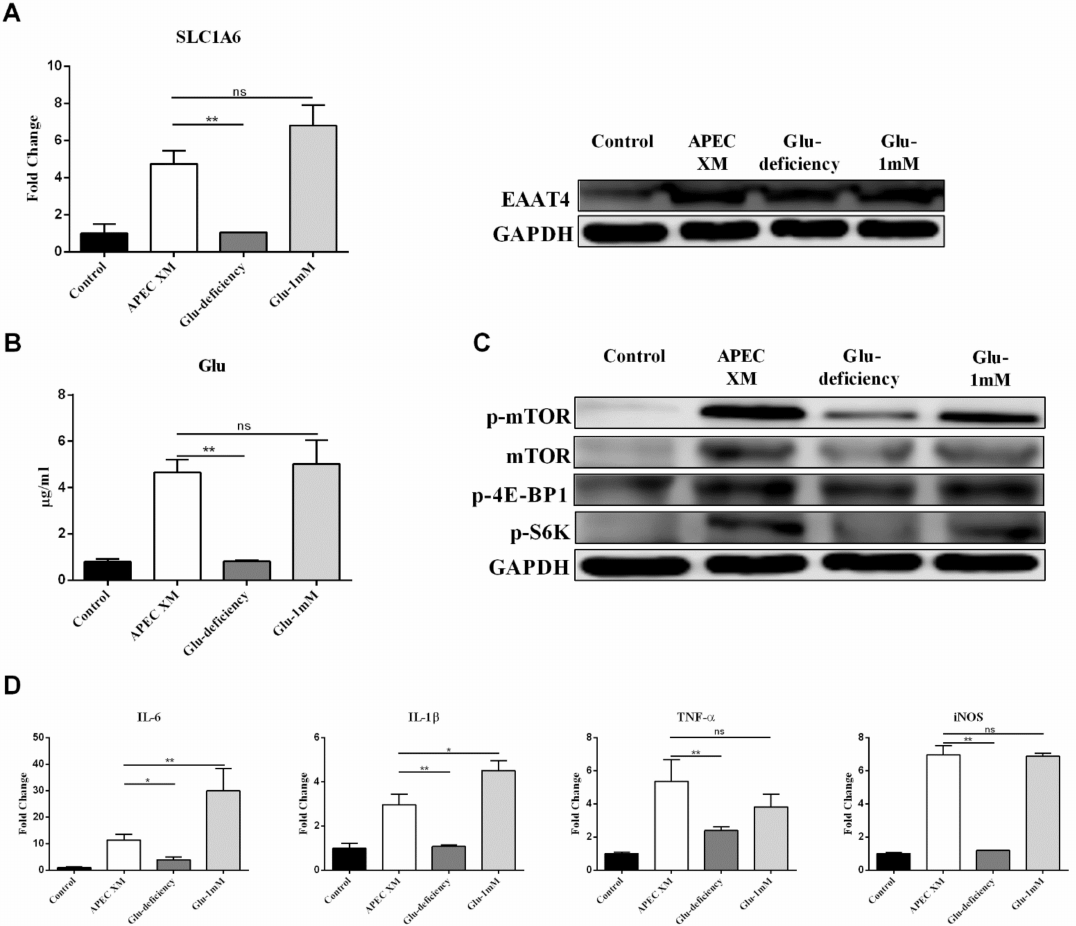
Figure 5. Glutamate involved in APEC XM-induced the expression of EAAT4, activation of mTOR pathway and inflam- mation in bEnd.3 Cells. ( A ) The transcription and expression levels of Slc1a6 in bEnd.3 cells in the Glu deficiency or the 1 mM Glu supplement medium compared with APEC XM infection cells by RT-PCR and western blot analyses. GAPDH and GAPDH were used as the reference control for RT-PCR and the blotting. The RT-PCR data were from one experiment representative of three independent experiments and were presented as mean ± SD. ( B ) The intracellular content of Glu in bEnd.3 cells in the Glu deficiency or the 1 mM Glu supplement medium was respectively significantly decreased and no significant difference compared with APEC XM infection cells. The data were from one experiment representative of three independent experiments and were presented as mean ± SD. ( C ) Western blotting showed the significant activation of the mTORC1 pathway in bEnd.3 cells in the Glu deficiency or the 1 mM Glu supplement medium. GAPDH was used as the reference control. ( D ) The mRNA expressions of pro-inflammatory factors in bEnd.3 cells in the Glu deficiency or the 1 mM Glu supplement medium compared with APEC XM-infected cells were shown. GAPDH was used as the reference control. Data are from one experiment representative of three independent experiments, with three to six replicates per group. Data represent means ± SD. ns: not significant, * p < 0.05, ** p <